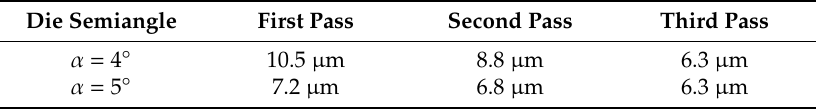
Table 3. Dependence of t on the number of passes and α .